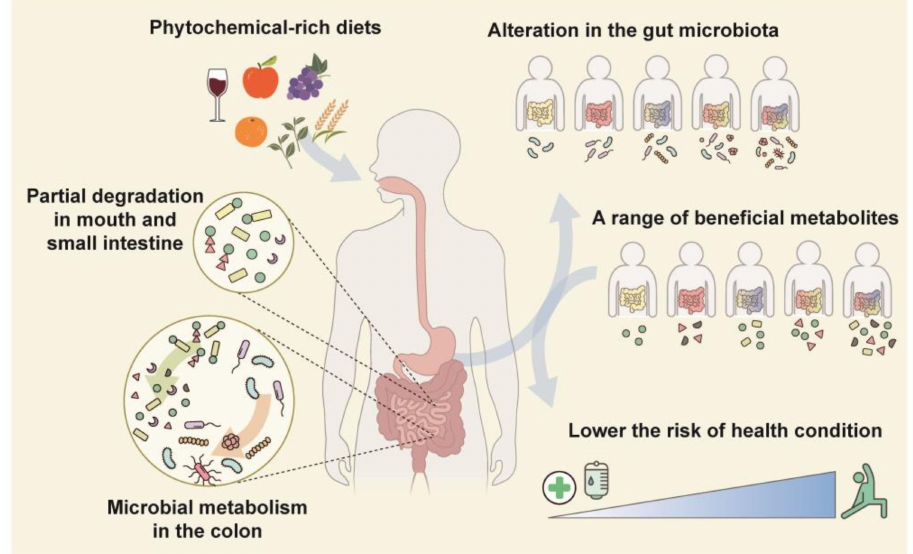
Figure 1. Relationship between the colonic microbiota and phytochemicals. Most phytochemicals in fruits and vegetables are transformed by colonic-microbiota-derived enzymes. Phytochemical metabolites are absorbed into the host circulation and modulate colonic microbiota composition or diversity. An individual’s unique colonic microbiota produces a variety of metabolites which are linked to the risk of several